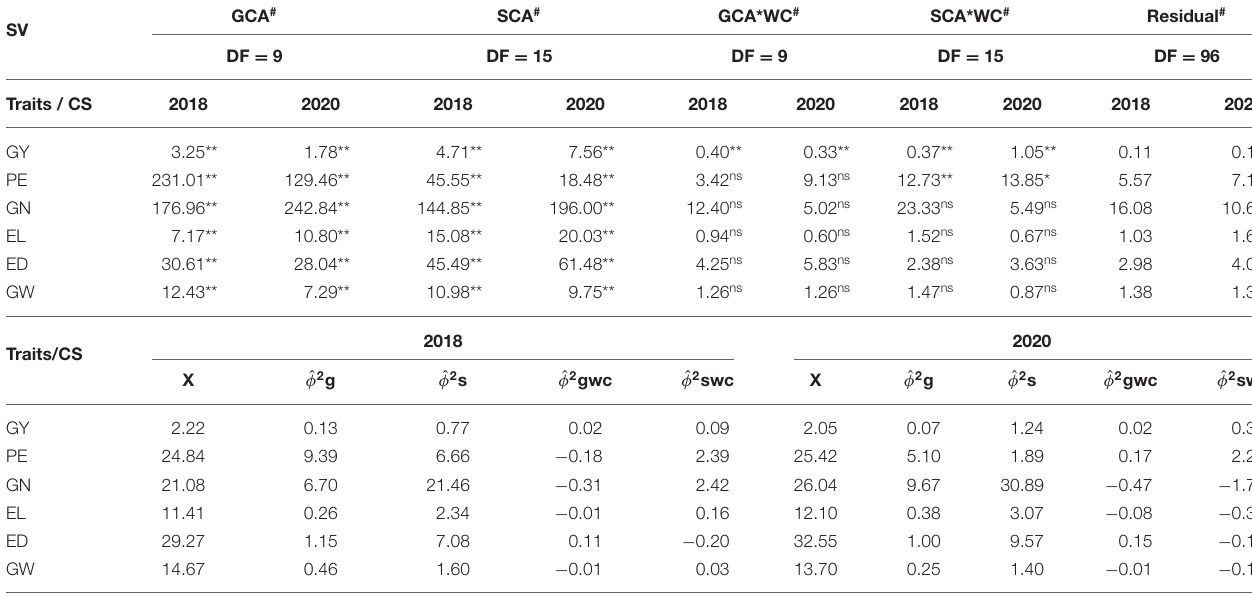
TABLE 4 | Mean square estimates of popcorn genotypes for GCA and SCA and the residual and mean squares of combining ability effects on agronomic traits in distinct water conditions (WCs) and crop seasons (CSs). SV